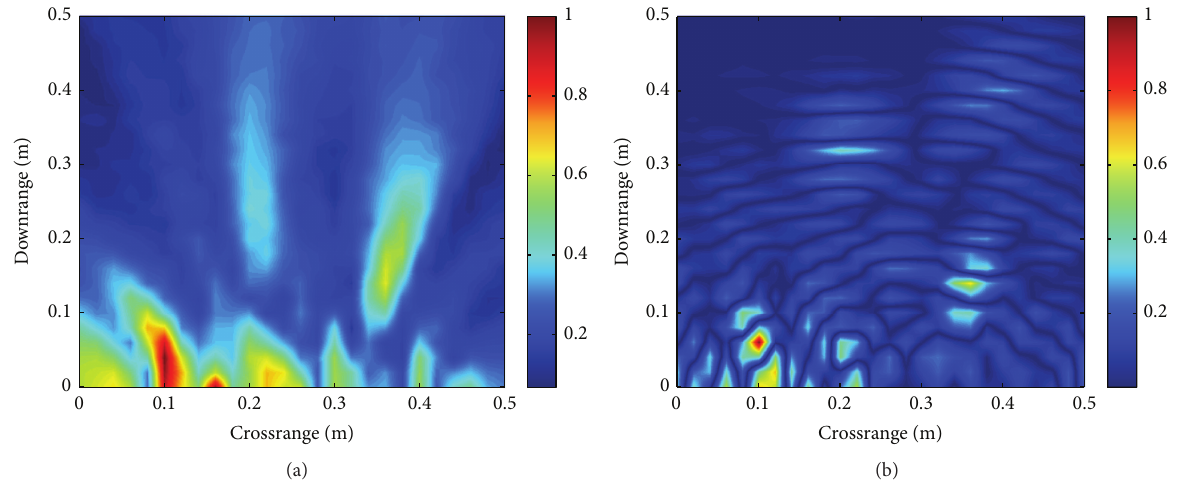
Figure 2: Imaging result (a) obtained by using the conventional TRI and (b) obtained by using signal amplitudes at 𝑡 focus .